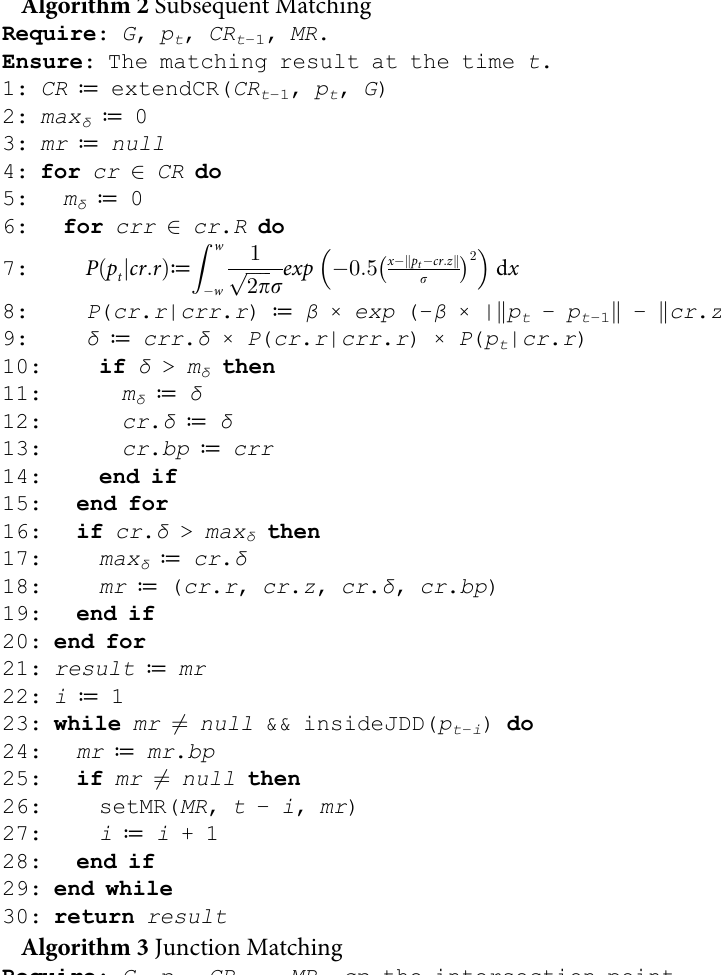
Algorithm 2 Subsequent Matching